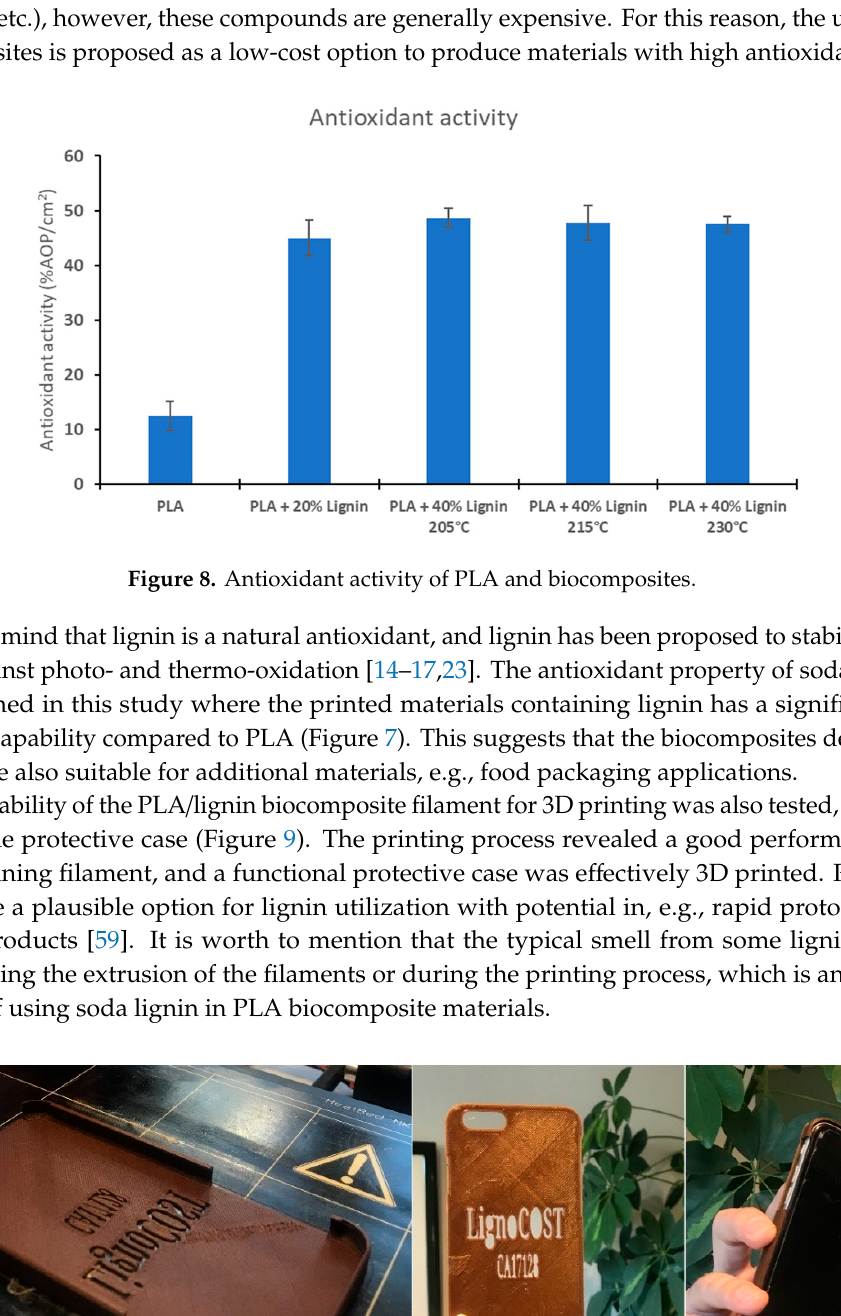
Figure 9. 3D printing of a smartphone protective case with PLA/lignin biocomposite filament .